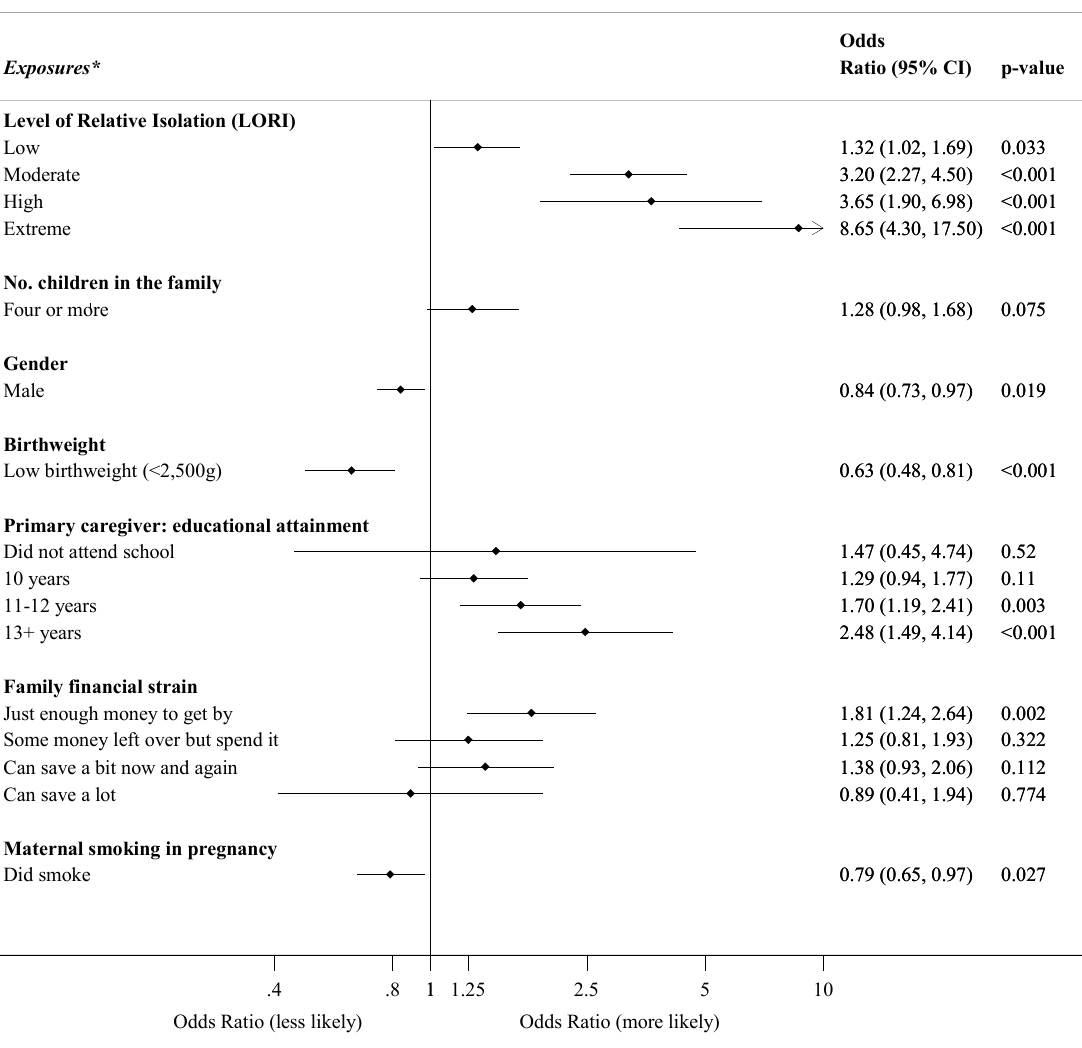
Figure 1. Multivariate relationship between location of residence and other demographic factors, infant and maternal characteristics with breastfeeding duration of three months or more, in Western Australian Aboriginal children aged 0–17, whose primary caregiver is their birth mother